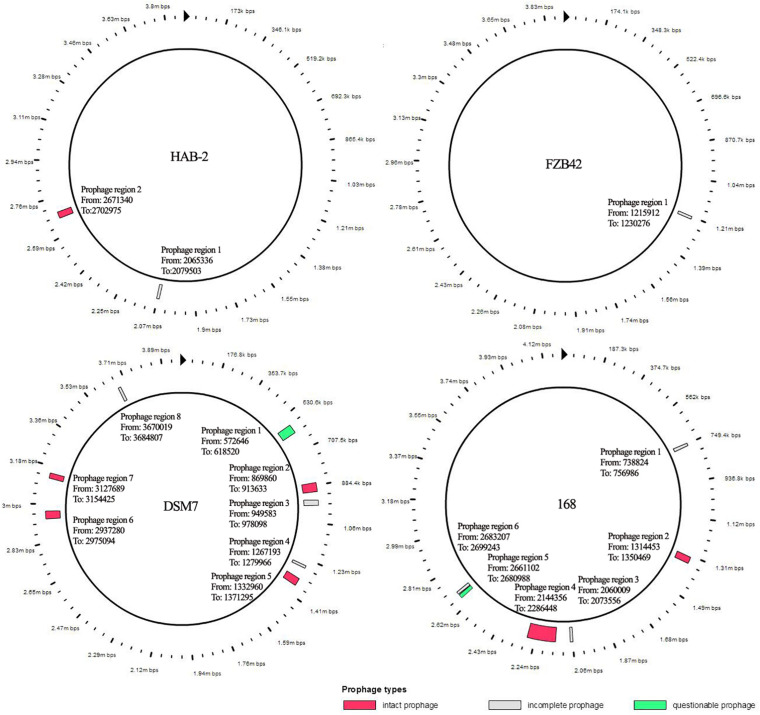
Prophage of B. velezensis HAB-2 and comparison with other Bacillus spp. All prophage regions in different colors code according to completeness, a prediction of whether the region contains an intact or incomplete prophage. If the region’s total score is < 70, it is marked as incomplete (gray); if within 70–90, it is marked as questionable (green); if > 90, it is marked as intact (red). HAB-2: two prophage regions identified, of which one is intact (Pr 2, with 46 CDS) and one is incomplete (Pr 1, 12 CDS). Bacillus velezensis FZB42: one prophage region identified, which is incomplete (Pr 1, 25 CDS). Bacillus amyloliquefaciens DSM7: eight prophage regions identified, of which four are intact (Pr2, 46 CDS; Pr 5, 49 CDS; Pr 6, 27 CDS; and Pr 7, 29 CDS), three are incomplete (Pr 3, 24 CDS; Pr 4, 18 CDS; and Pr 8, 17 CDS) and one is questionable (Pr 1, 63 CDS). Bacillus subtilis 168: six prophage regions identified, of which two are intact (Pr 2, 49 CDS and Pr 4, 198 CDS), three are incomplete (Pr 1, 20 CDS; Pr 3, 13 CDS; and Pr 6, 23 CDS) and one is questionable (Pr 5, 21 CDS).